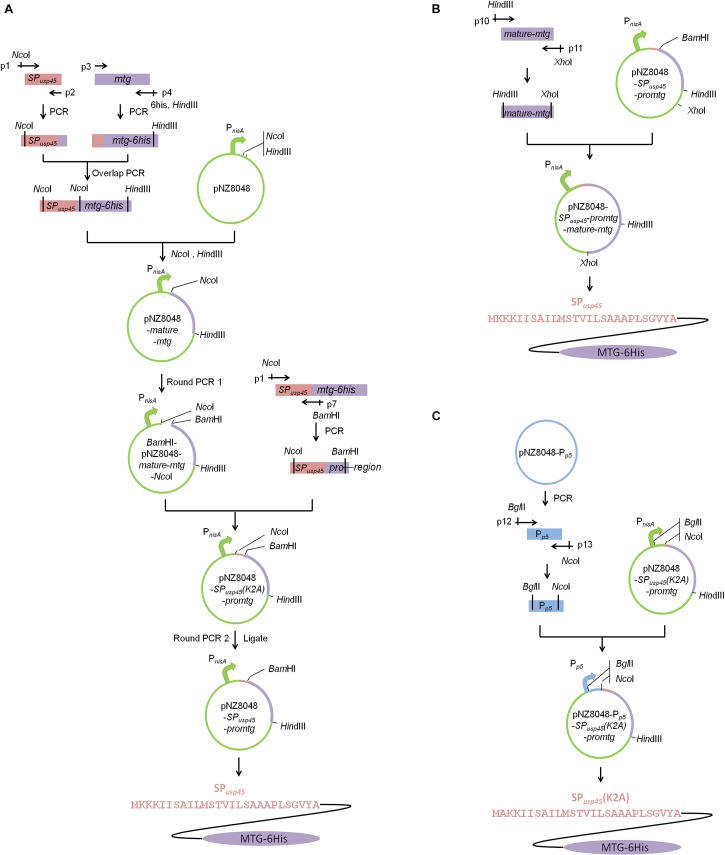
Schematic illustrations of vector constructions. Construction of pNZ8048-SPusp45-promtg and pNZ8048-Pp5-SPusp45(K2A)-promtg. (A) The construction of pNZ8048-SPusp45-promtg, which promoter is PnisA. (B) The construction of pNZ8048-SPusp45-promtg-mature-mtg, which promoter is PnisA. (C) The construction of pNZ8048-Pp5- SPusp45(K2A)-promtg, which promoter is Pp5.